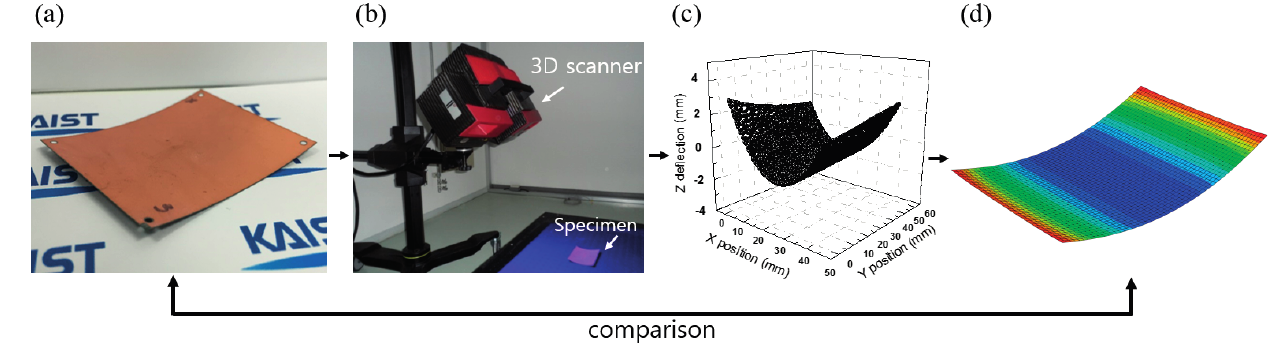
Figure 2. Warpage analysis procedure: ( a ) The bilayer specimen with the size of 44 × 56 mm is prepared which is bent due to residual stress at room temperature; ( b ) Shape measurement by non-contact 3D scanner; ( c ) Curvature fitting for calculation of the residual stress; ( d ) FEM simulation result of the room temperature warpage.